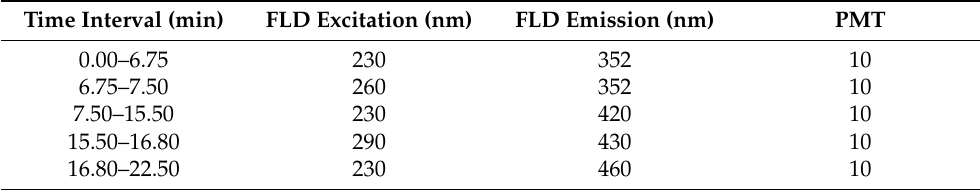
Table 1. Conditions set for the detection by HPLC-FLD. PMT = photomultiplier tube. Time Interval (min) FLD Excitation (nm) FLD Emission